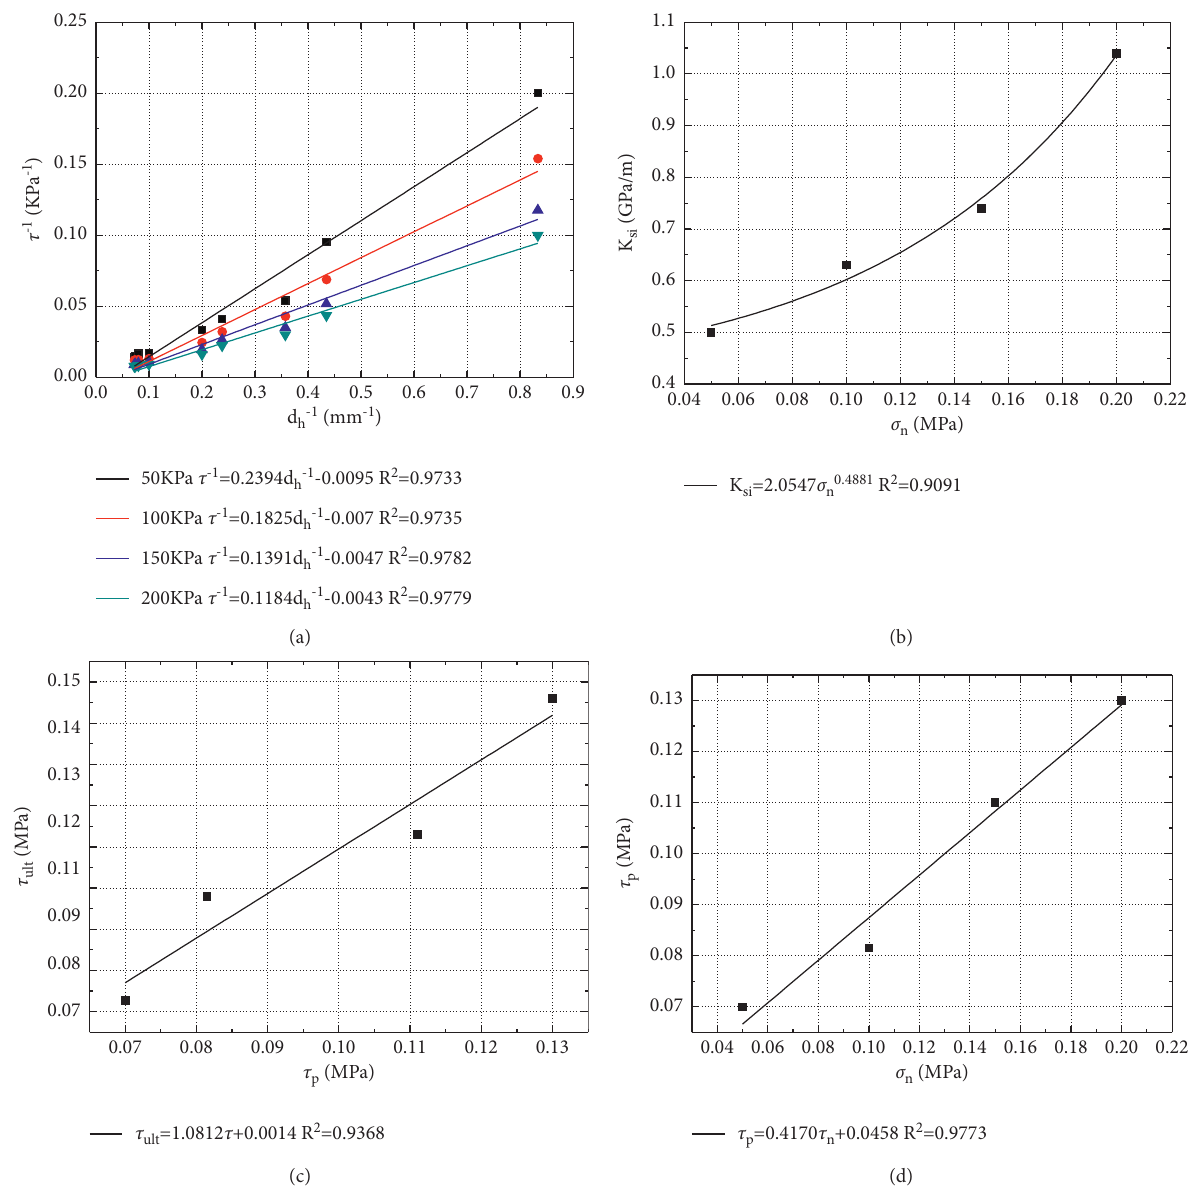
Figure 2: The fitting curves of shear strength parameters. (a) Linear relationship (( 1/ τ ) − ( 1/ d (c) Linear relationship ( τ